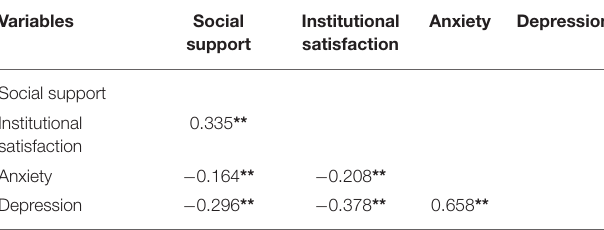
TABLE 3 | The correlation among key variables. TABLE 4 | Multiple linear regression analysis of factors associated with